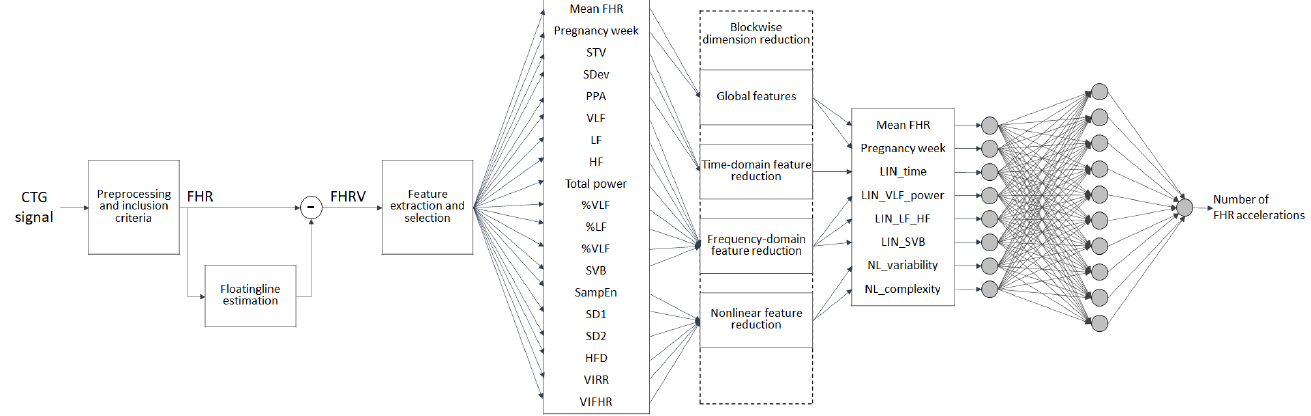
Figure 1. Methodological workflow. (STV = Short Term Variability; SDev = Standard Deviation; PPA = peak-to-peak am- plitude; VLF and %VLF = power and its percentage in the Very Low Frequency band; LF and %LF = power and its per- centage in the Low Frequency band; HF and %HF = power and its percentage in the High Frequency band; SVB = Sympa- tho-Vagal Balance; SampEn = Sample Entropy; SD1 = Standard Deviation 1 perpendicular to the line-of-identity obtained by Poincaré maps; SD2 = Standard Deviation 2 along the line-of-identity obtained by Poincaré maps; HFD = Higouchi Fractal Dimension; VIRR = Variability Index obtained by applying the Symbolic Dynamics technique to the RR time series; VIFHR = Variability Index obtained by applying the Symbolic Dynamics technique to the FHRV signal).